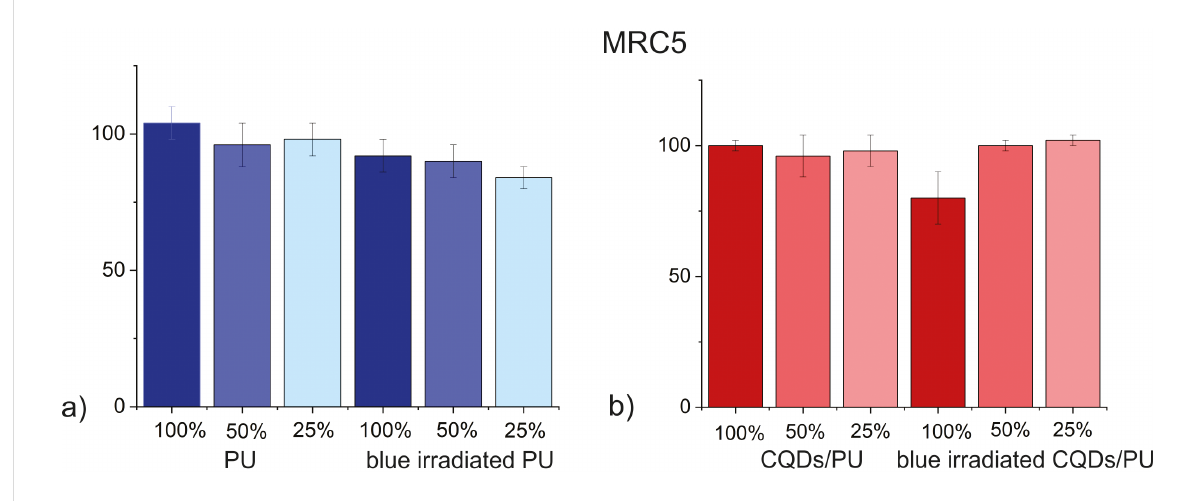
Figure 5: Viability of MRC5 after treatment with PU control (a) and CQDs/PU composite samples (b) using different extract concentrations. No cyto- toxicity effect of 50% of extract in the cultivation medium of the CQDs/PU composite on MRC5 cells was detected. All tests were carried out in tripli-